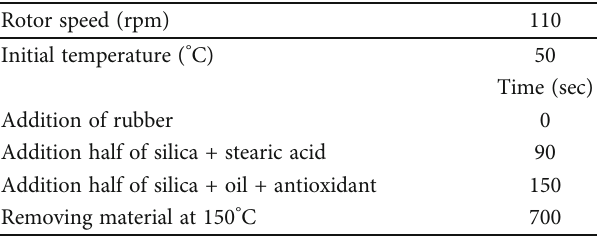
Table 2: The compounding procedure.